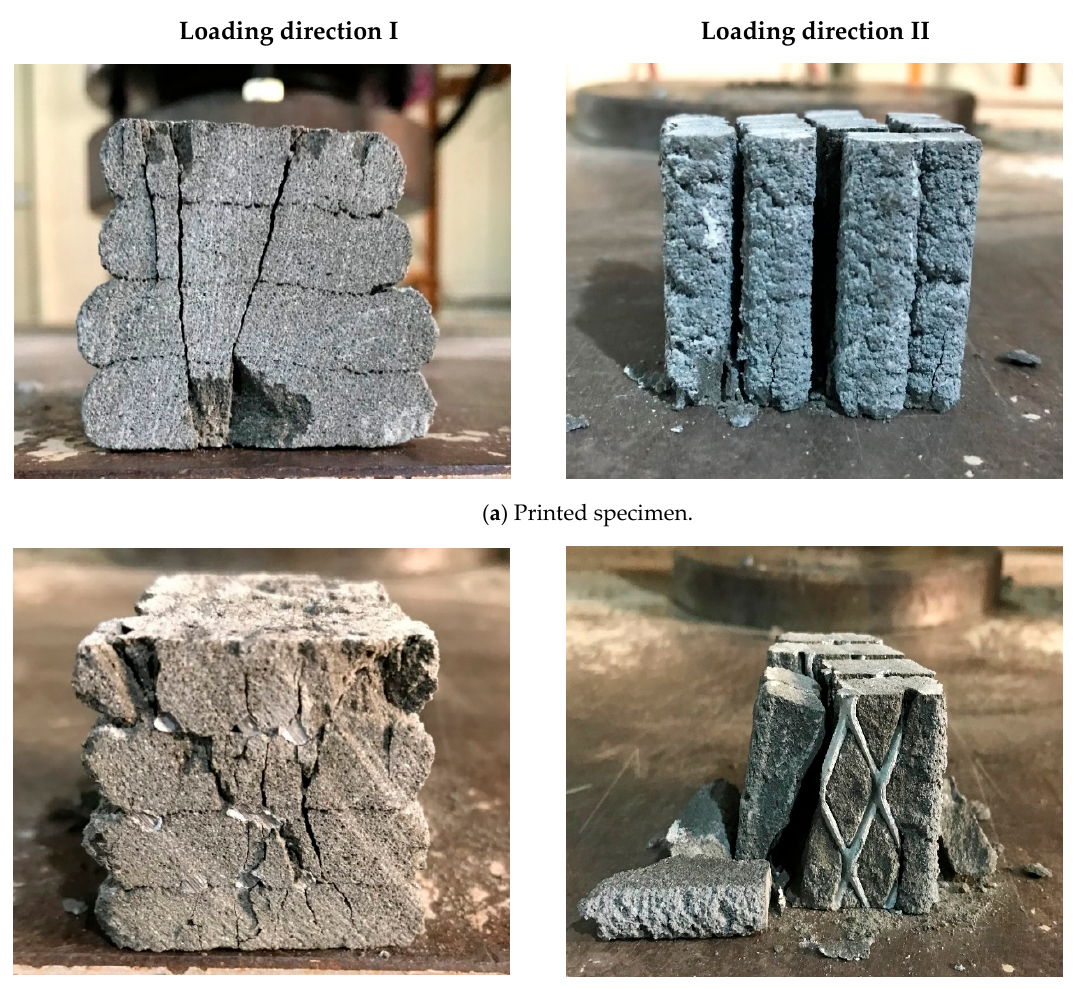
Figure 8. Compressive test results.